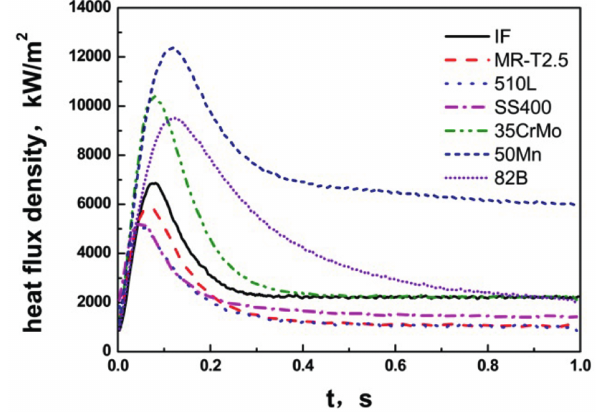
Figure 14: Heat flux density of the copper chill plate changes over time in droplet experiments of various